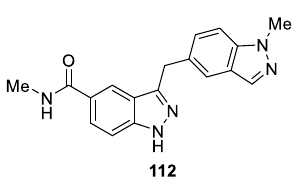
Figure 22. Chemical structure of 3-benzylindazoles derivative 112 .